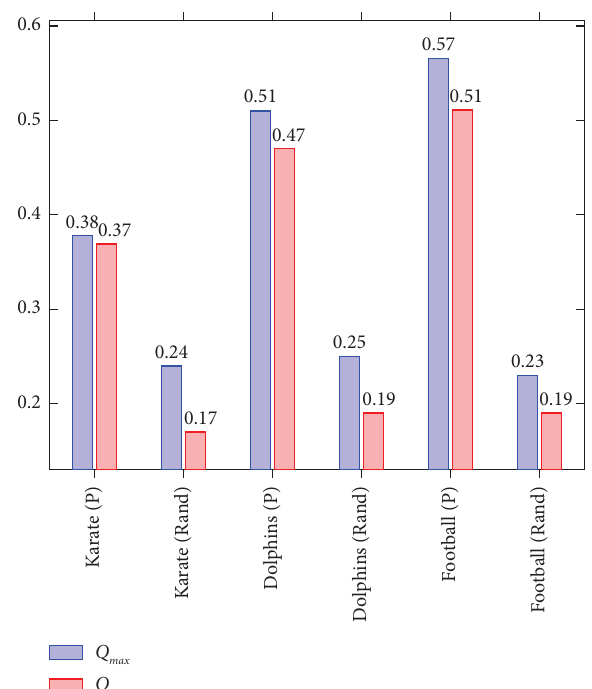
Figure 9: Comparison of the performance of the proposed initial population generation function ( P ) with random initial population generation function (Rand).